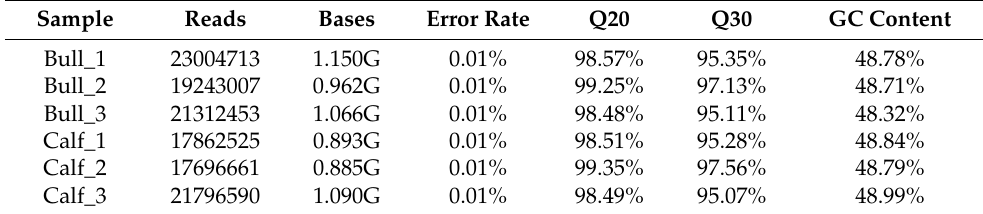
Table 2. Raw reads sequencing data results and